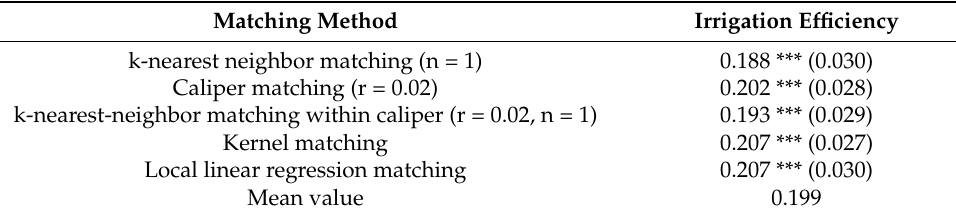
Table 6. Average treatment effect of propensity score matching